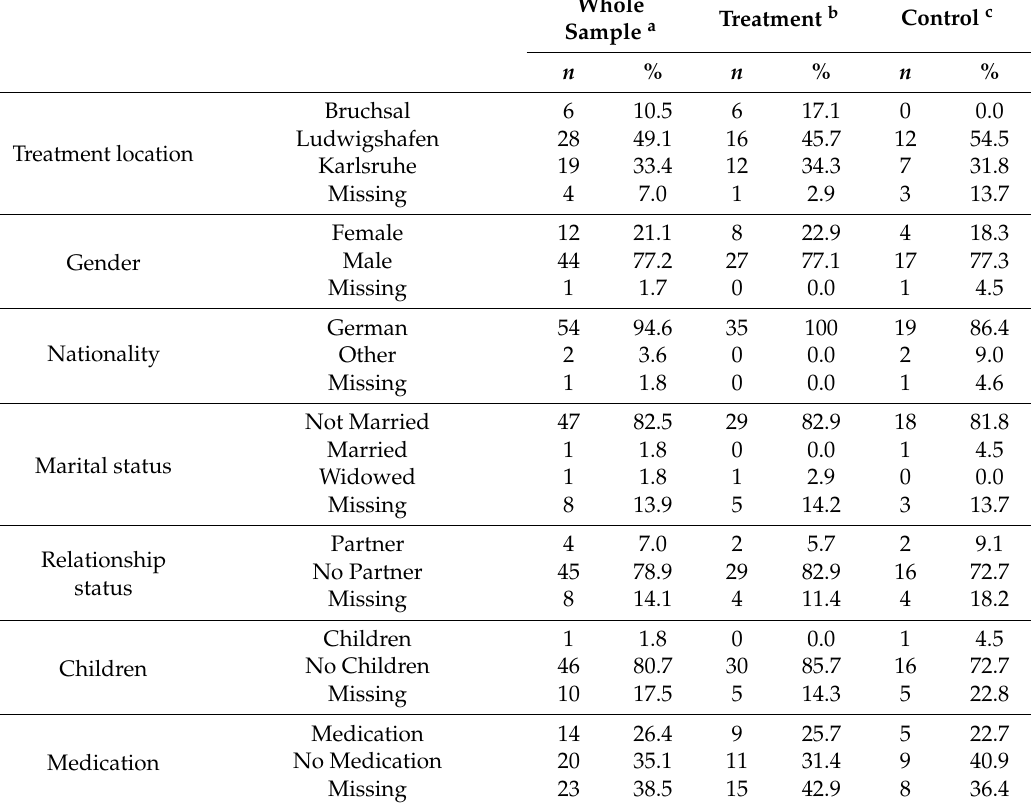
Table 1. Demographic data of the participants for the whole sample and for each group